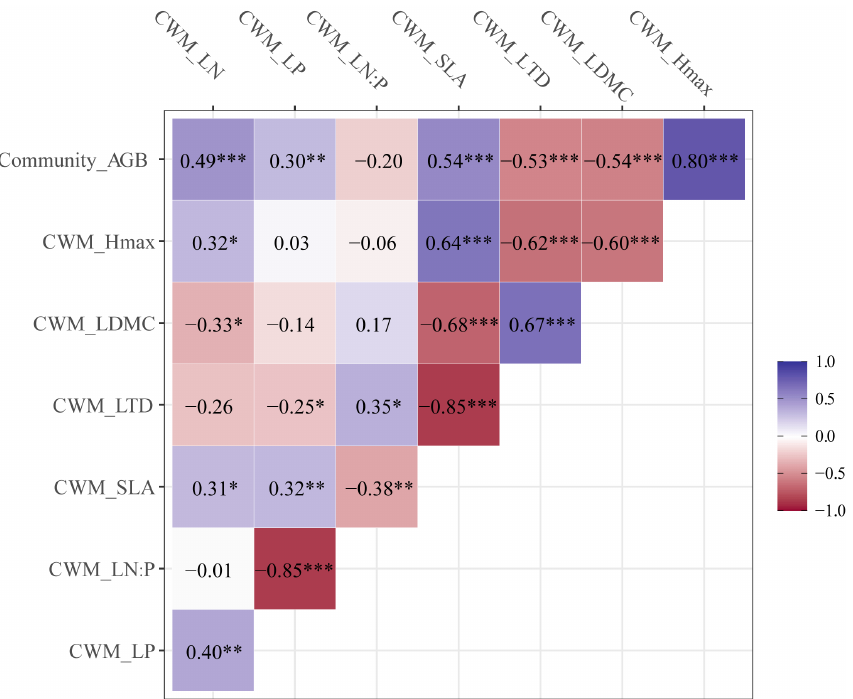
Figure 2. Correlation coefficients of community AGB and community level functional traits. * p < 0.05; ** p < 0.01; *** p < 0.001; LN, leaf N content; LP, leaf P content; LN/P, leaf N/P ratio; SLA, specific leaf area; LTD, leaf tissue density; LDMC, leaf dry matter content; H max , maximum plant height.